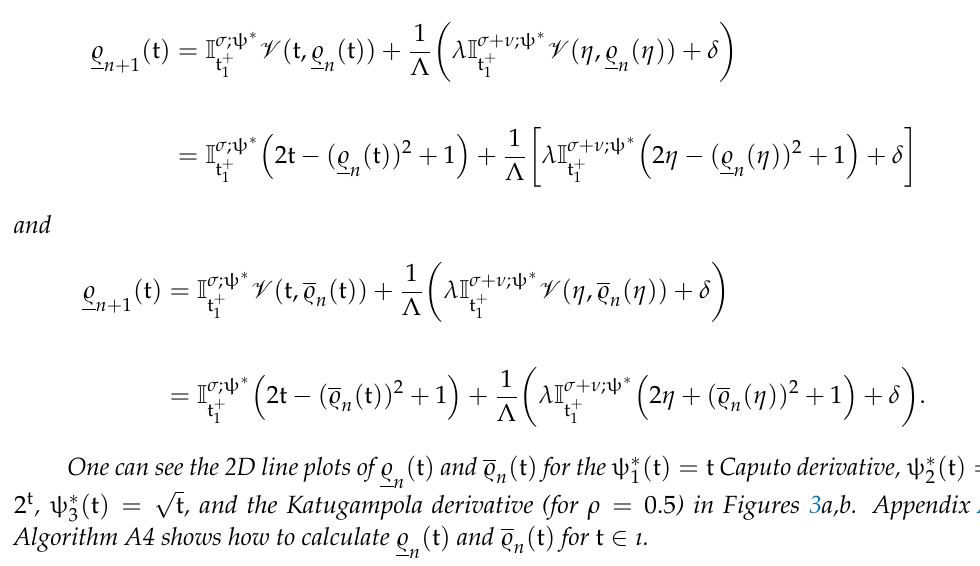
Table 3. Numerical results of (cid:36)